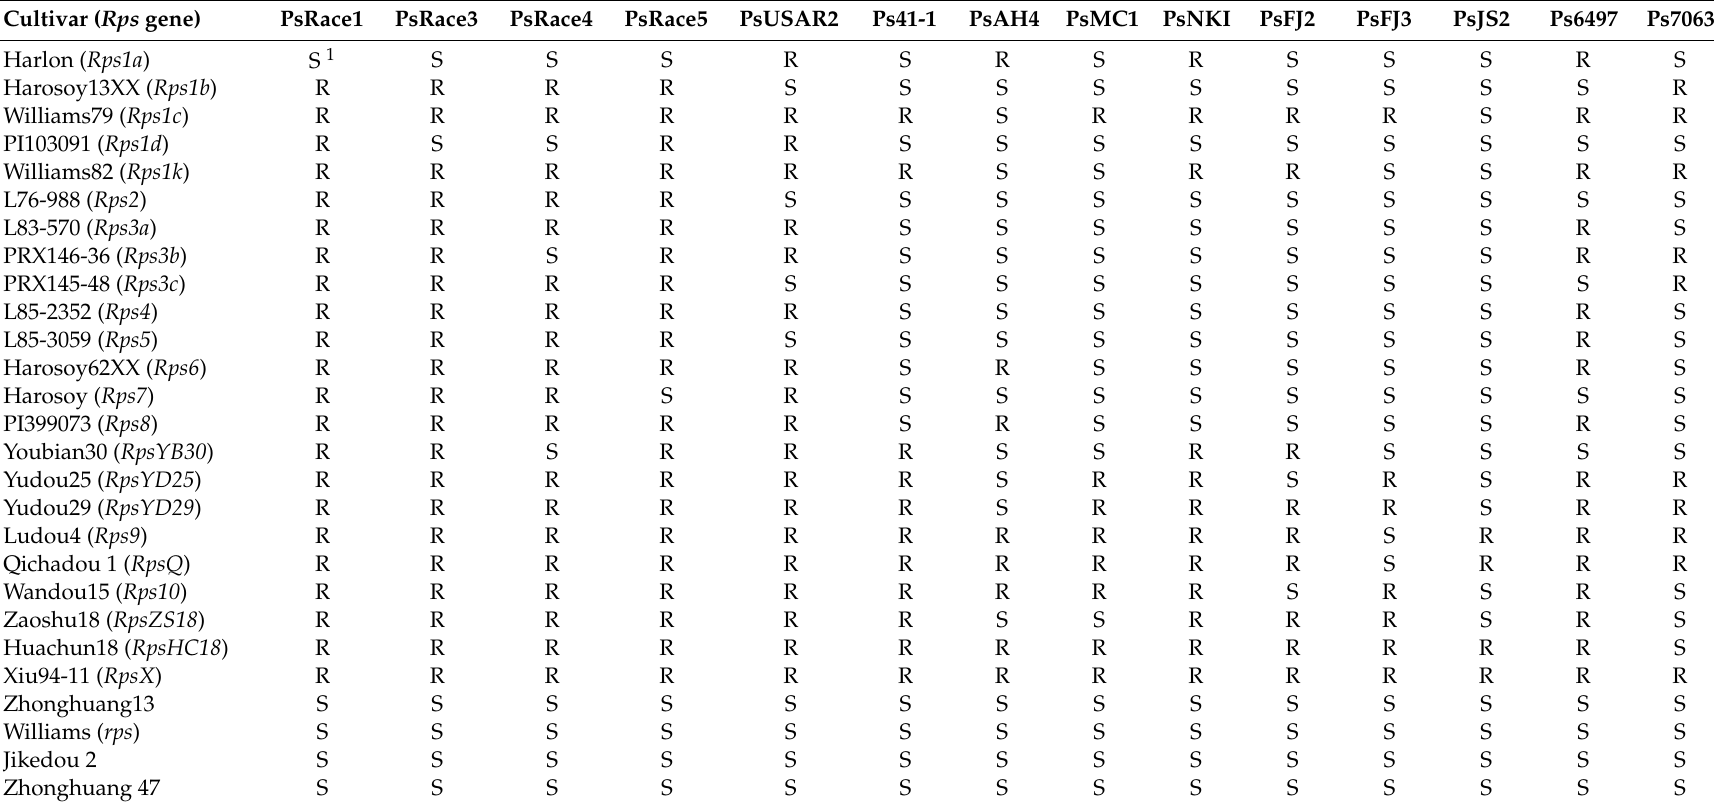
Table 1. Phenotypic responses of 27 soybean cultivars to 14 Phytophthora sojae